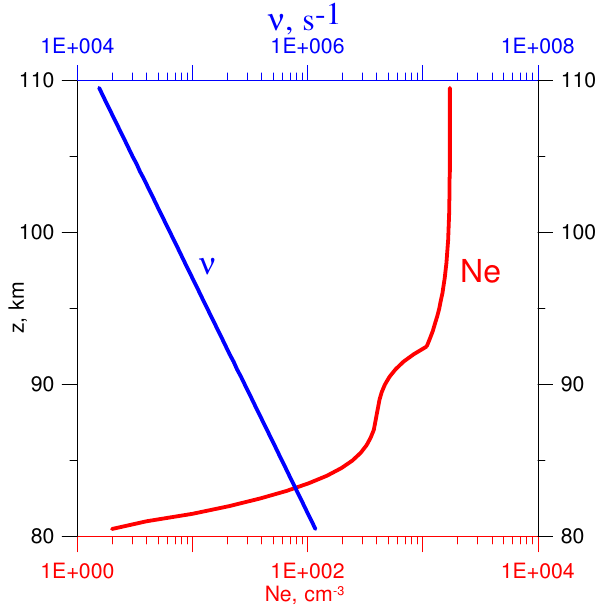
Fig. 4. The electron density and the collision frequency profiles in the night IRI model used in the numerical